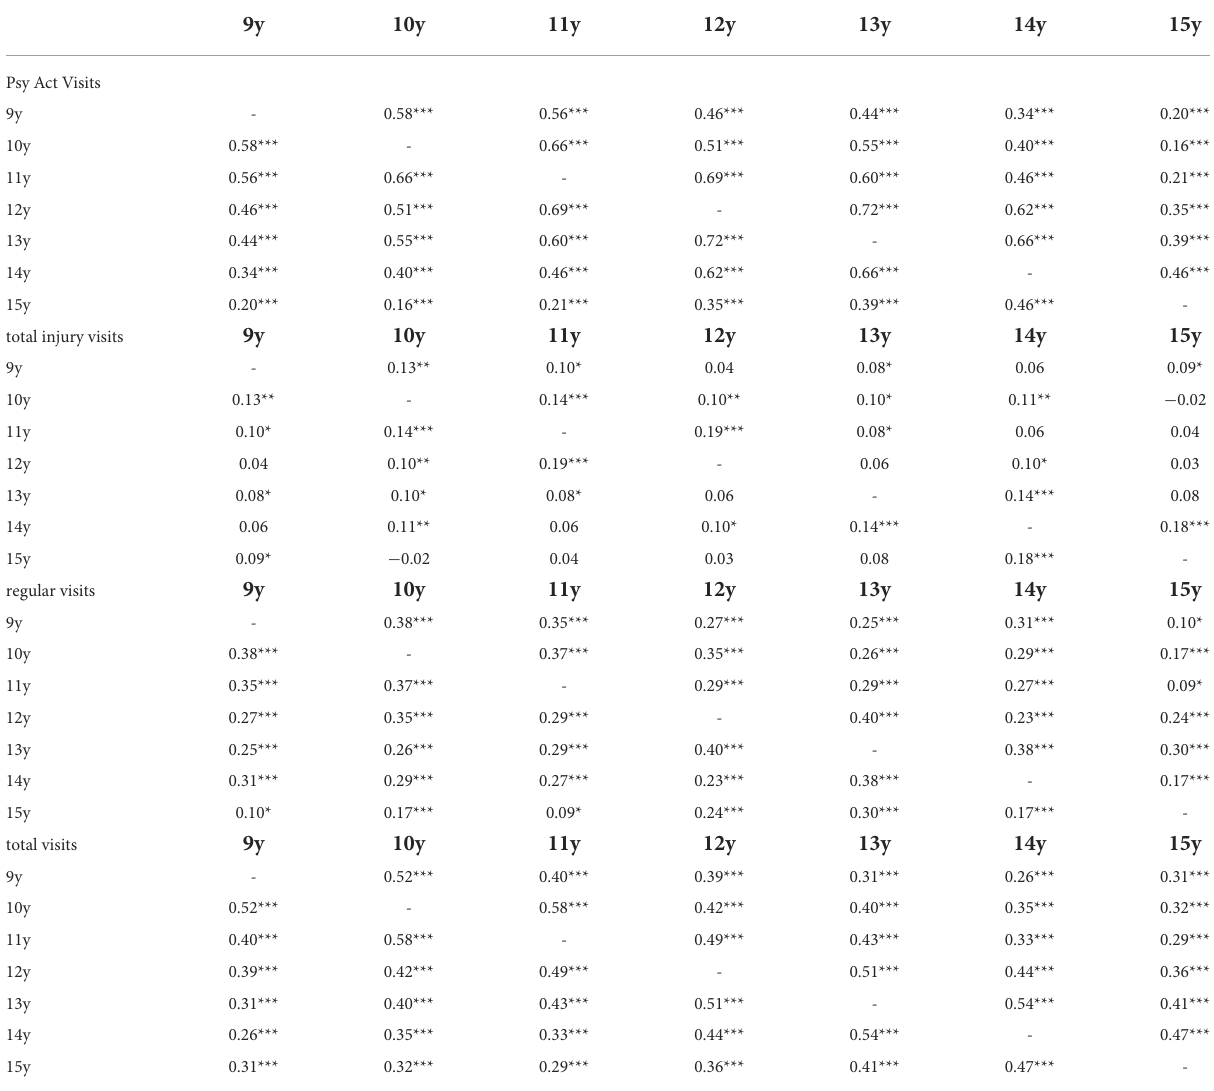
TABLE 2 Correlations (truncated